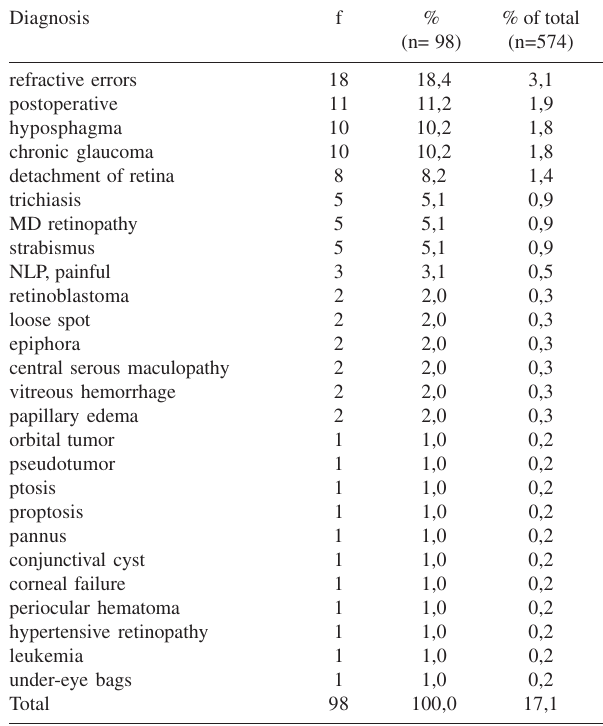
Table 5 - Diagnostics of patients with “others oculars modifications” that looked for ophthalmology emergency